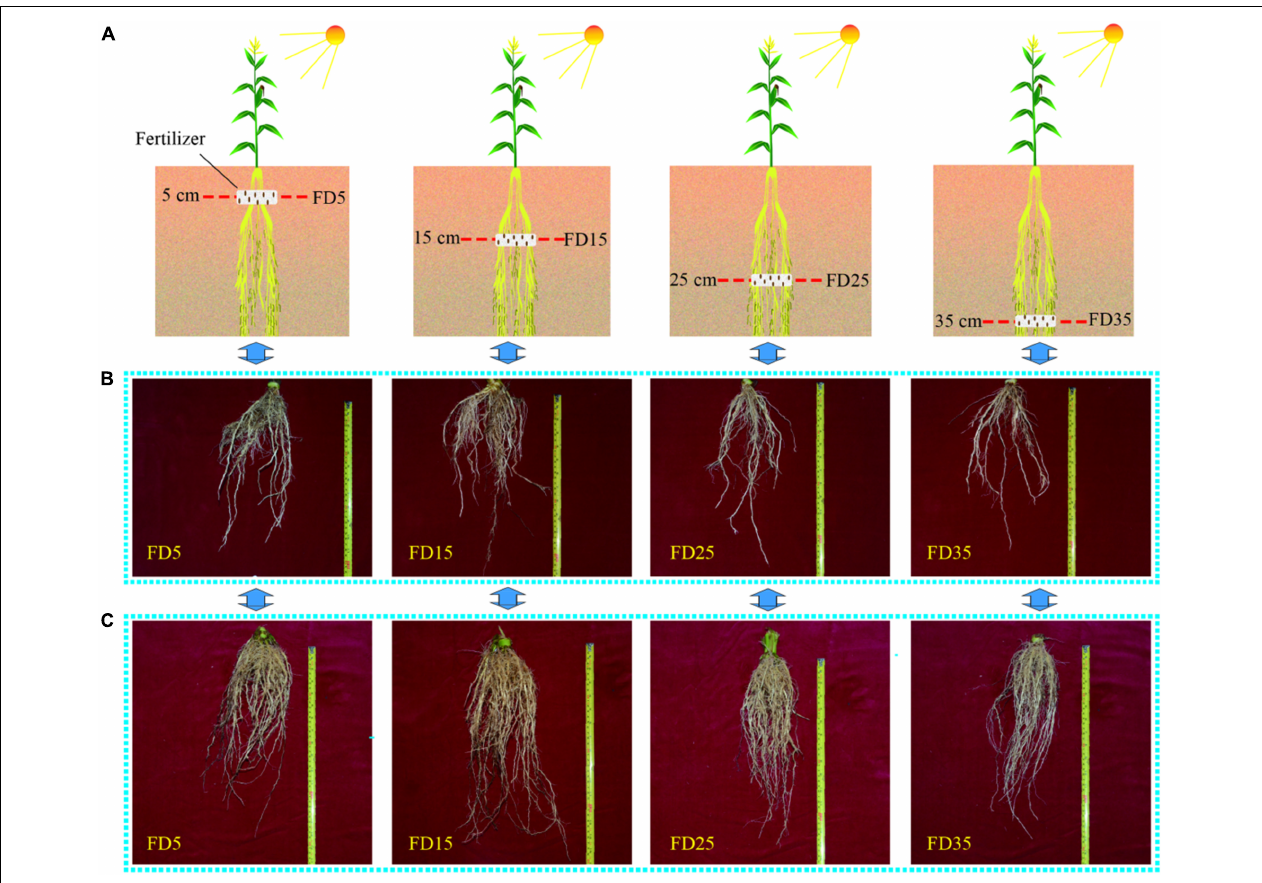
FIGURE 2 | The schematic diagram of different fertilizer application depths (A) ; maize root system in field soil profile at the six-leaf stage (B) and tasseling stage (C) . FD5, fertilizer application at a depth of 5 cm; FD15, fertilizer application at a depth of 15 cm; FD25, fertilizer application at a depth of 25 cm; and FD35, fertilizer application at a depth of 35